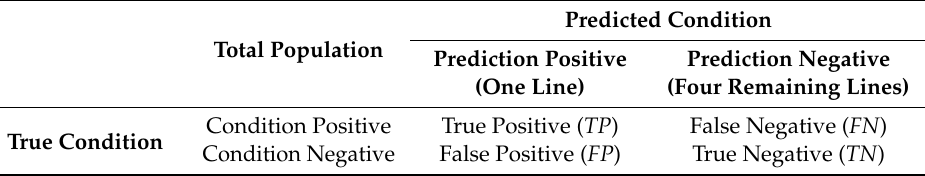
Table 1. A general confusion matrix.